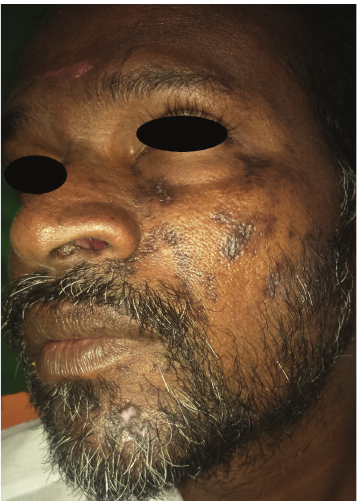
Figure 6: Intraoral healed ulcers after a